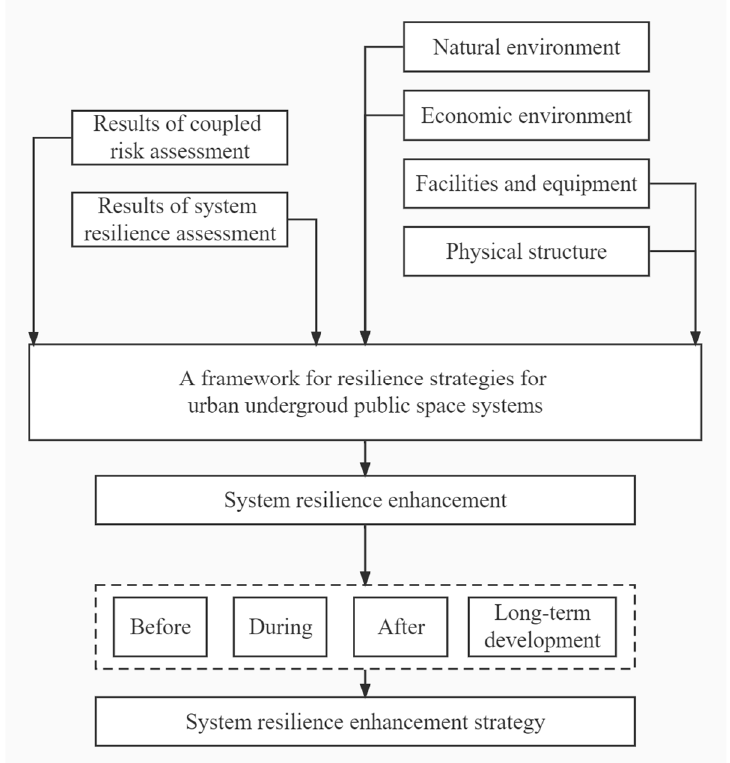
Figure 5. The proposed resilience enhancement strategy for the underground public space (UPS) system.